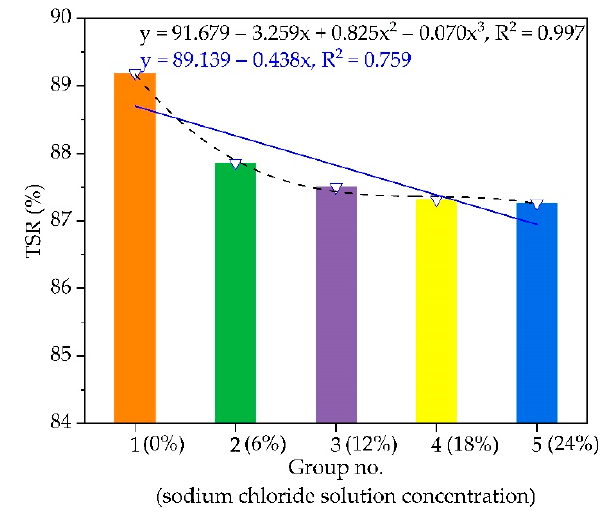
Figure 7. The variation of TSR with different chloride salt concentrations.